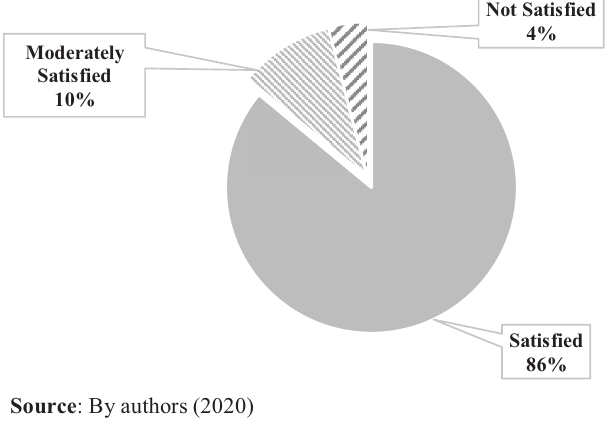
Figure 6. Road users ’ level